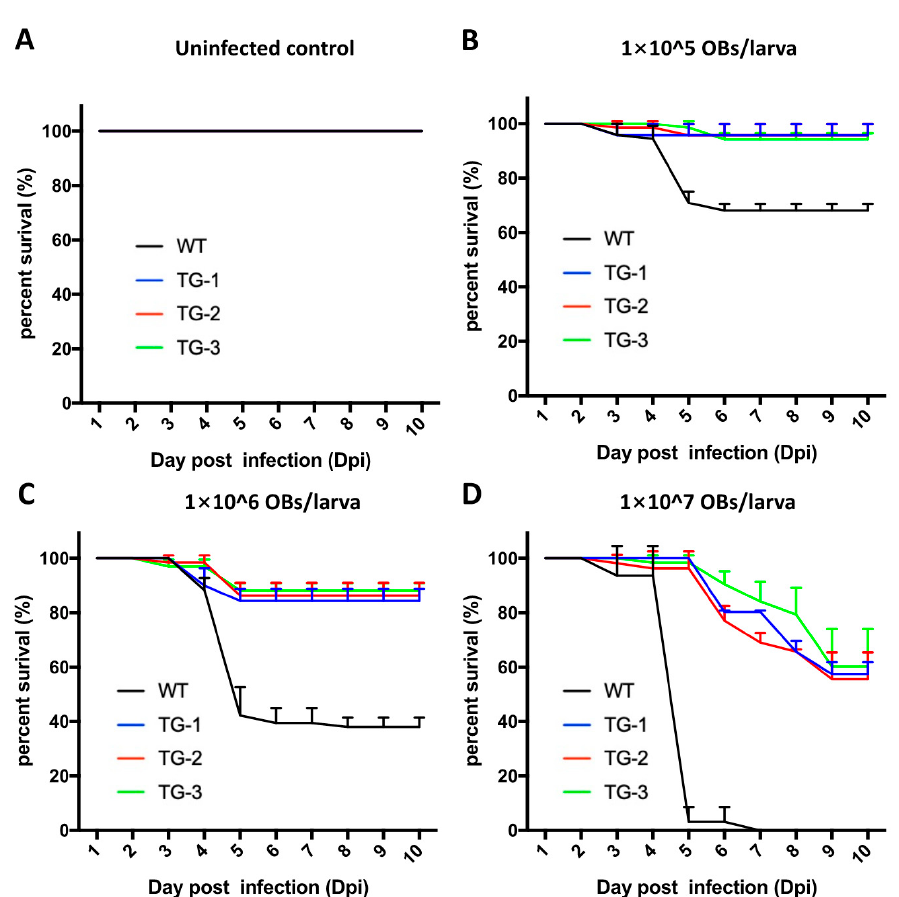
Figure 2. Resistance to BmNPV infection in transgenic and wild-type silkworms. ( A ) Survival rate analysis of TG and WT silkworms without treatment with BmNPV. ( B – D ) Survival rate analysis of TG and WT silkworms after inoculation with ( B ) 1 × 10 5 OBs/larva, ( C ) 1 × 10 6 OBs/larva, and ( D ) 1 × 10 7 OBs/larva. Values are the means of three independent replicates with 30 larvae in each replicate. Statistical analysis of mortality was conducted 10 days after inoculation with